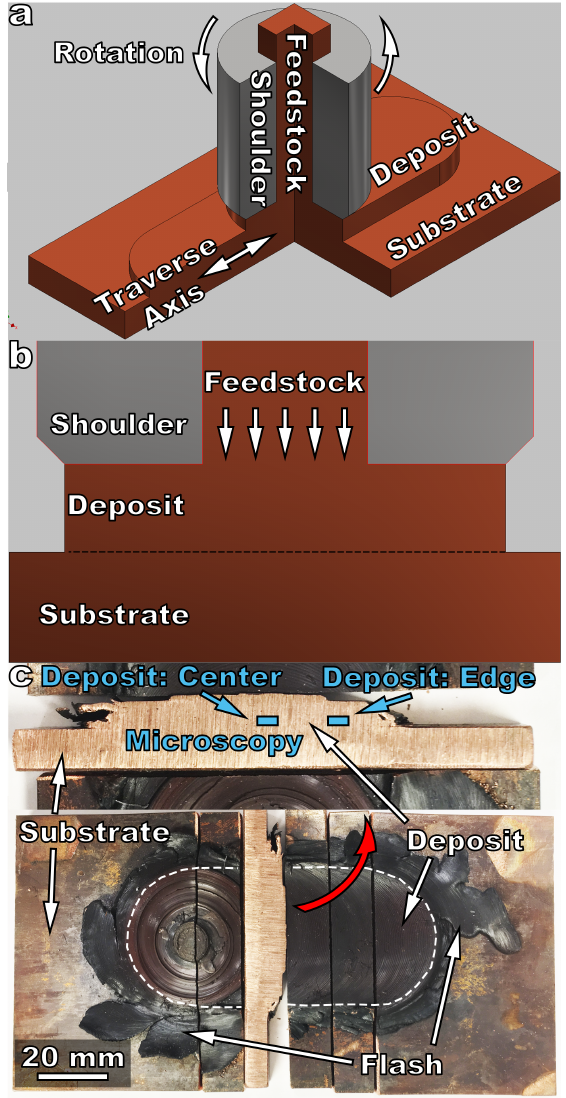
Figure 1. AFS-D schematics and resulting Cu deposit. ( a ) shows the AFS-D process in perspective; ( b ) presents the process in cross section (looking down the traverse axis); ( c ) contains a photograph of a Cu deposit after the completion of processing, with a section rotated to provide a similar view to ( b